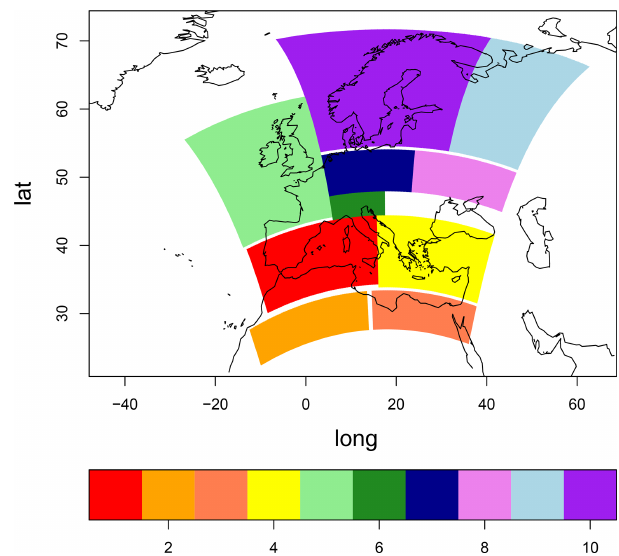
Figure 2. Domain